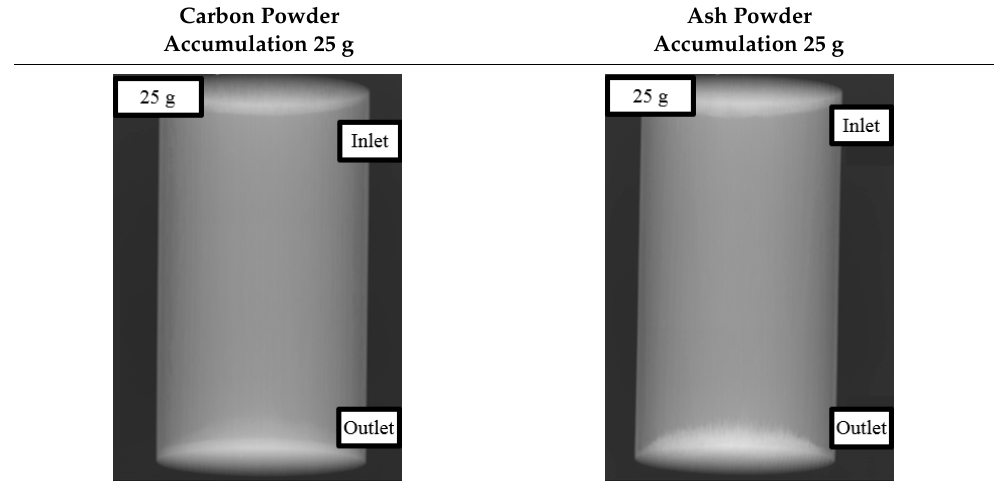
Table 9. Visual comparison of carbon powder accumulation and ash powder accumulation. Carbon Powder